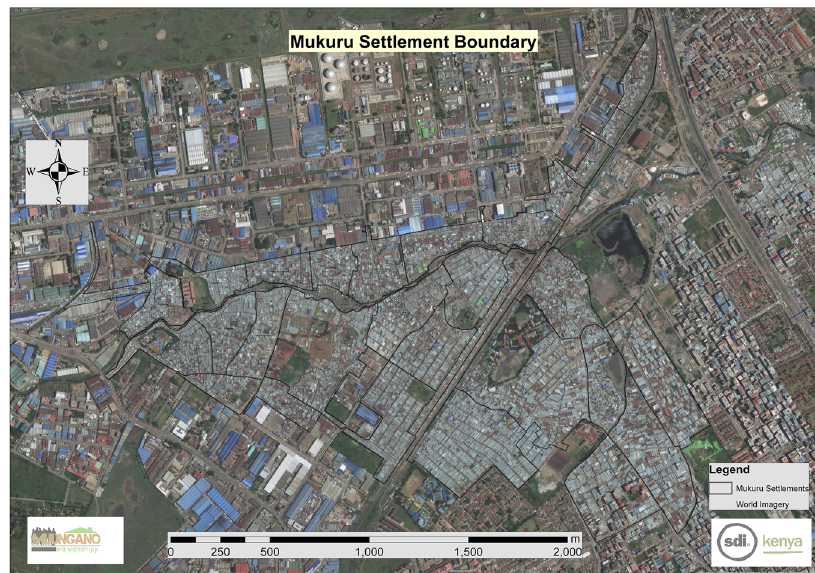
Fig. 1 Mukuru informal settlement boundaries. Map provided by Mukuru Youth Initiative and Muungano wa Wanavijiji, Slum Dwellers